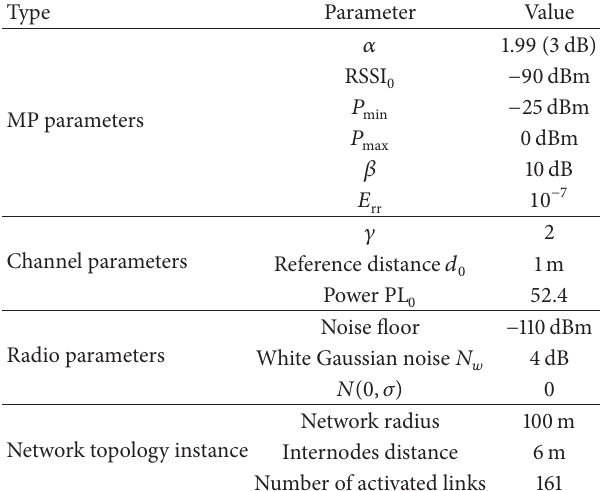
Table 1: Simulation parameters.